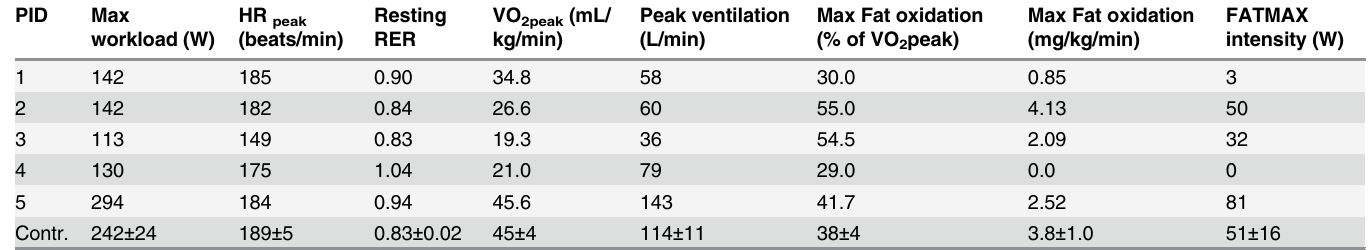
Table 3. Graded CPET exercise test characteristics of controls and patients. HRpeak = peak heart rate; RER = respiratory exchange ratio. Mean ± SEM is